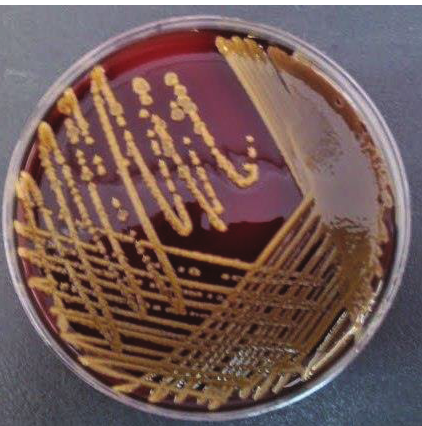
Figure 1: Yellow colonies of Chryseobacterium indologenes on blood